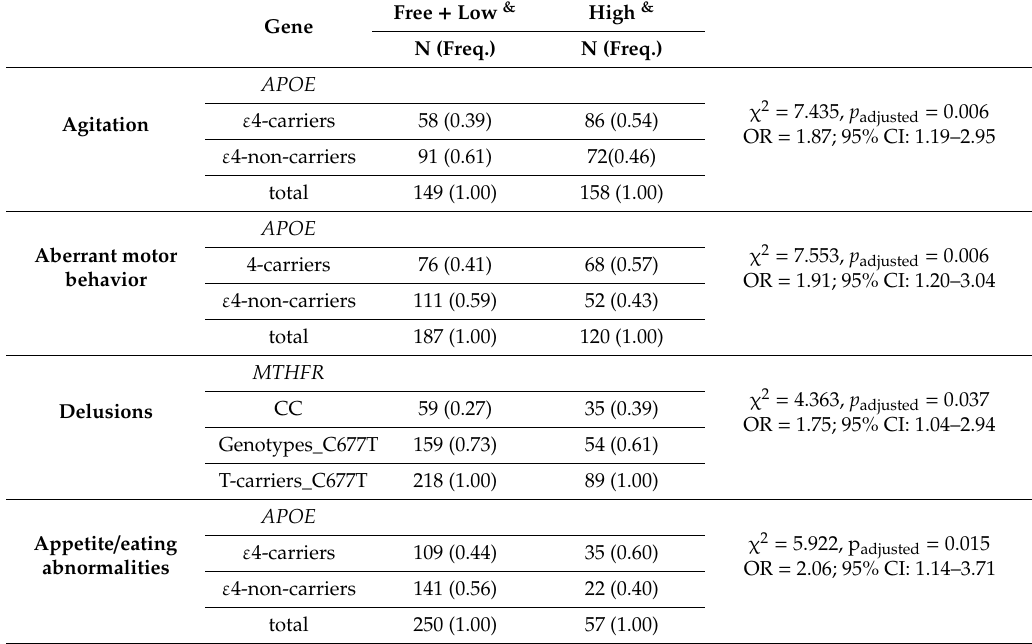
Table 6. Genetic correlates related to single BPSD symptoms in our Italian Alzheimer’s Disease cohort according to di ff erent values of “severity*frequencies” (exhaustive CHAID data mining